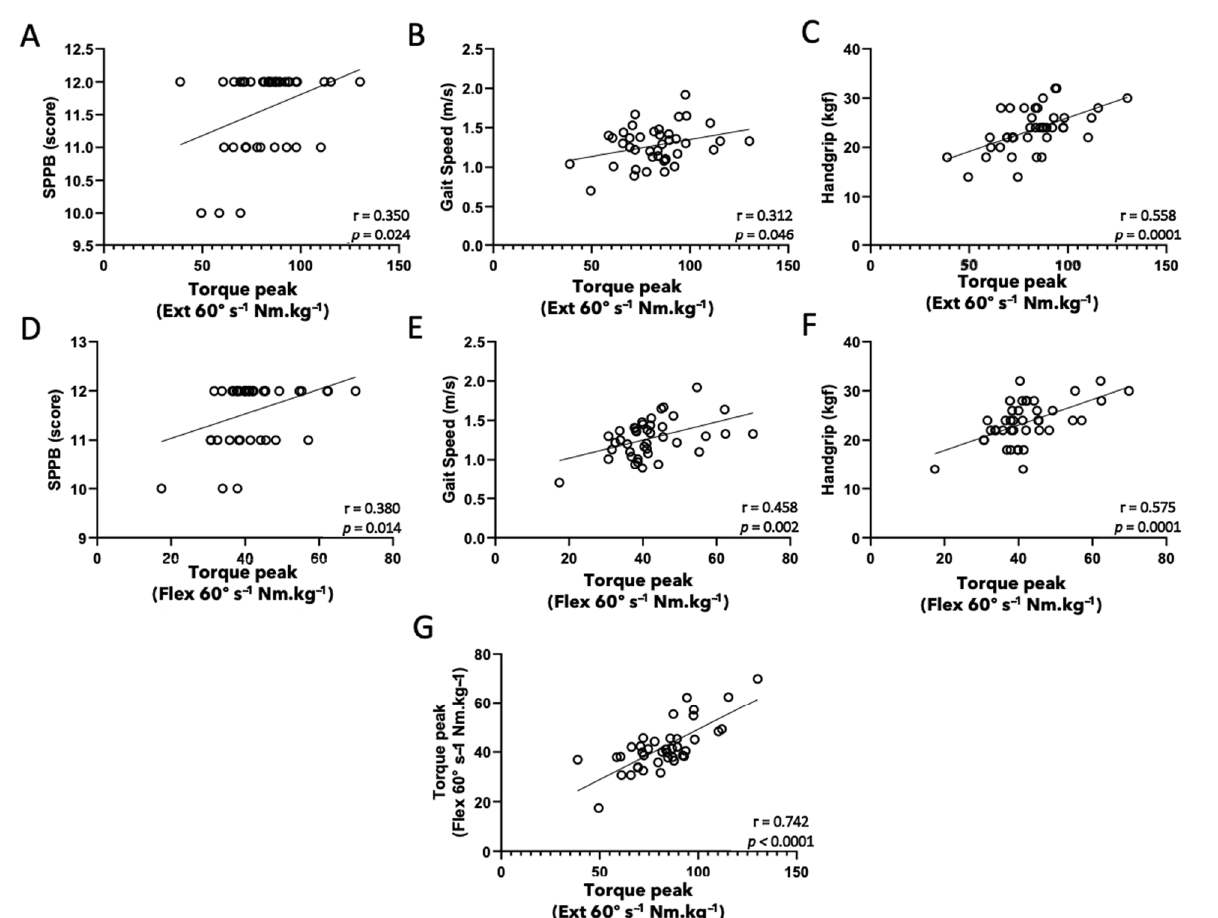
Figure 3. Pearson’s coefficient correlation analysis of isokinetic tests of knee muscles at 60 degrees per second (extensor, ( A – C ); flexor, ( D – F )) and physical function tests (SPPB, ( A , D ); gait speed, ( B ) and handgrip, ( C , F )); between extensor and flexor knee muscles ( G ). Significance level: p < 0.05.